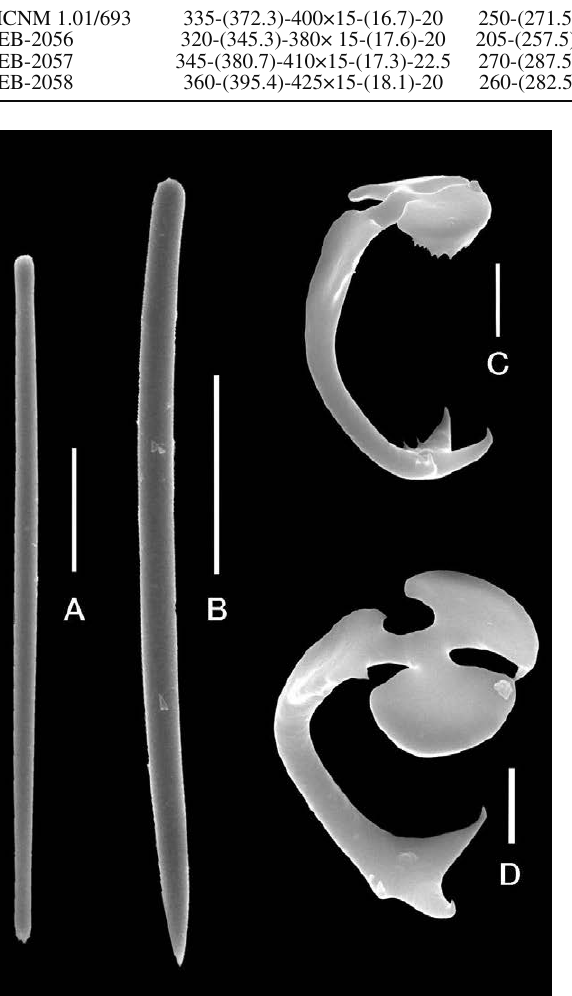
Table 7. – Spicule measurements of Iophon bipocillum n. sp. in μm. Values are expressed in minimum-average-maximum (μm). Material examined Choanosomal styles Tylotes (length×width) (length×width)